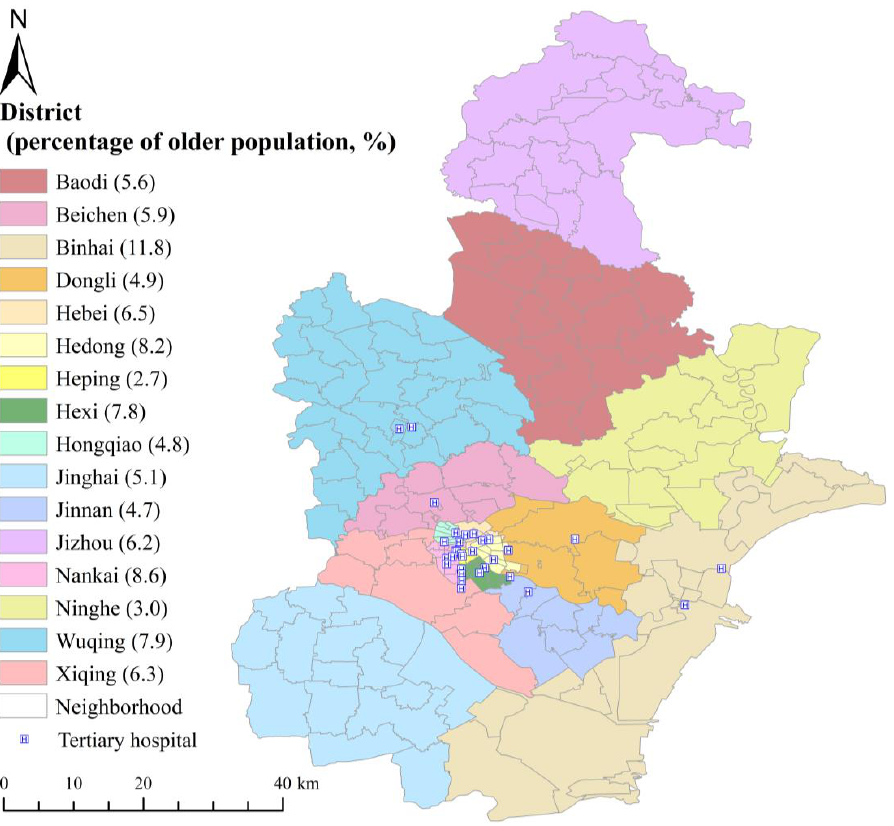
Figure 1. Distribution of tertiary hospitals and the percentage of the older population in all districts of Tianjin.